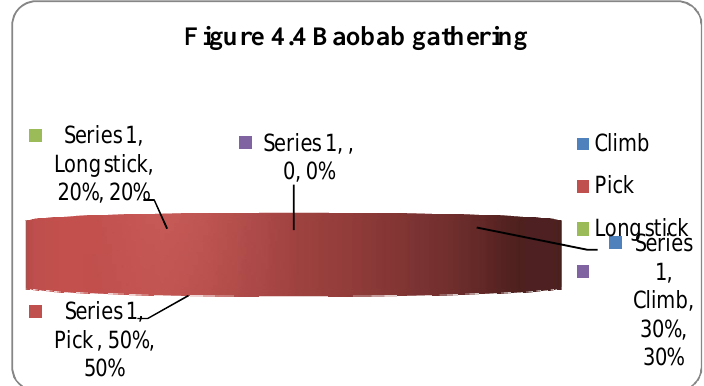
Figure 5: Percentage of Baobab gathering Figure 6: Baobab gathering by